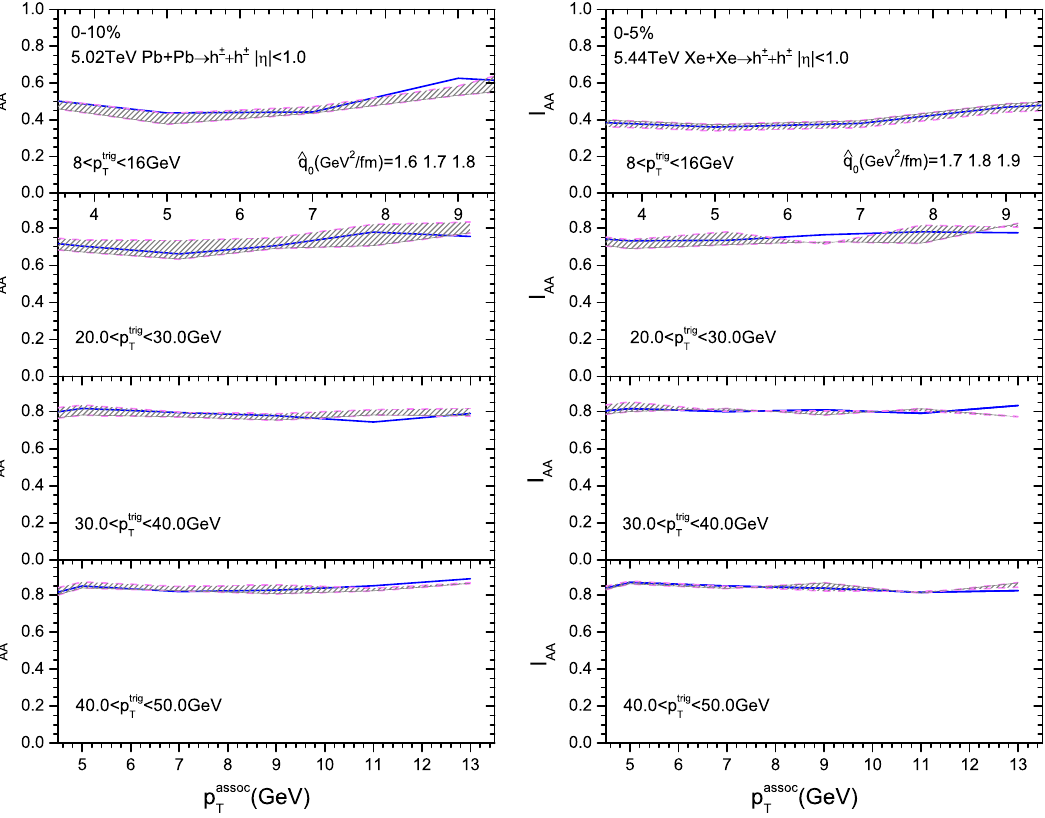
√ s NN = 5 . 02 TeV and in central Xe+Xe collisions at √